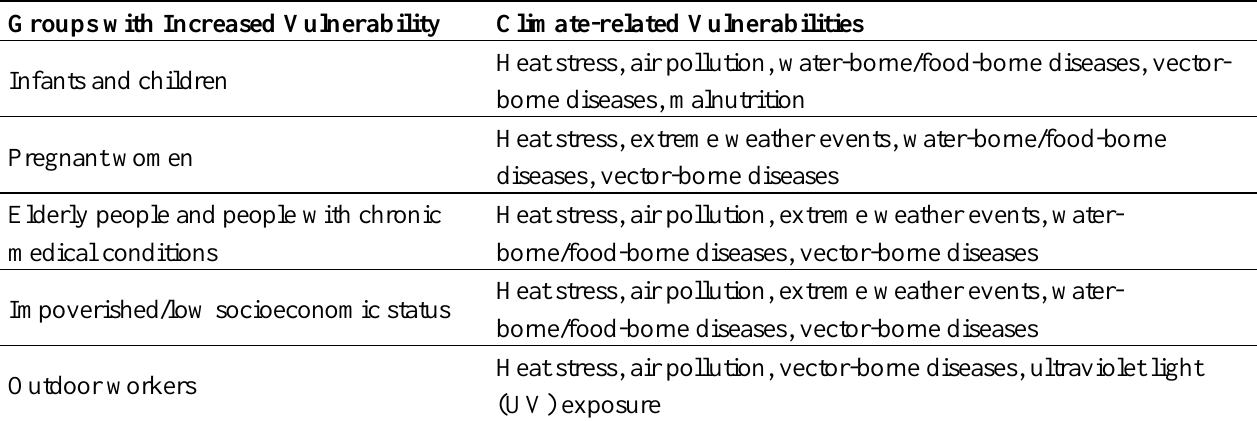
Table 1. Vulnerability to climate-sensitive health outcomes by subpopulation